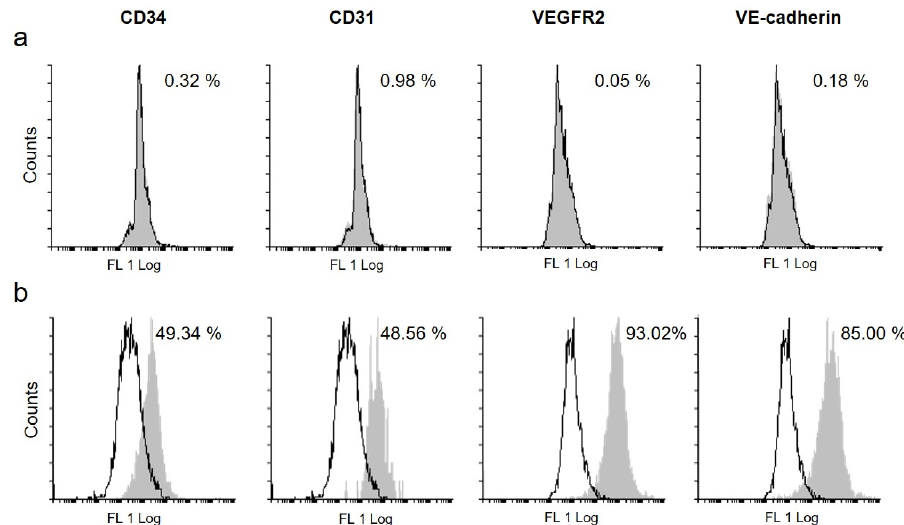
Figure 4. Protein expression study. Flow cytometry study of endothelial protein expression in ( a ) untreated cells or ( b ) Ad-MSCs cultured in induction medium for 21 days. Data are presented as percentage of positive cells (gray profile) in comparison with the isotype control (white profile). Abbreviations: VEGFR2, Vascular Endothelial Growth Factor Receptor 2; VE-cadherin, vascular endothelial cadherin .